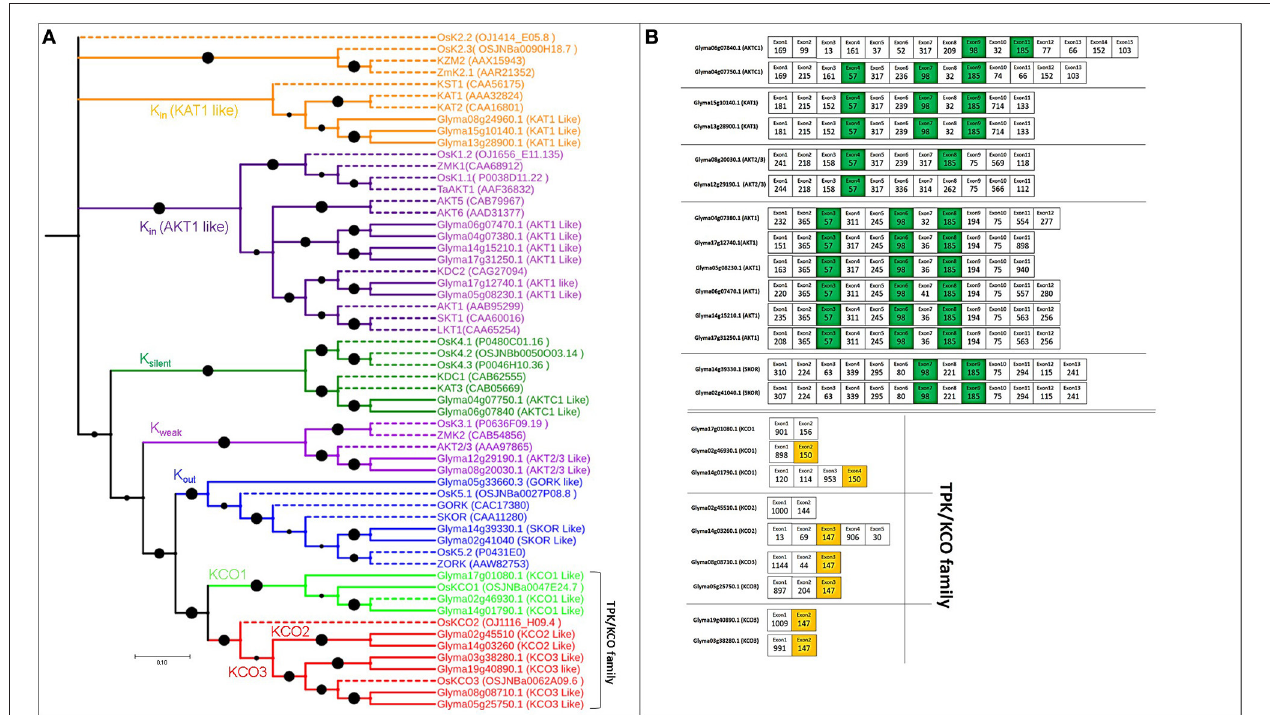
FIGURE 2 | Phylogenetic tree of putative Voltage-gated K + channel and TPK/KCO genes in soybean, with exon structure and splice site analysis. (A) Evolutionary relationships among genes encoding voltage-gated and TPK/KCO channels. Extensive functional analysis identified K in , K out , K weak , and K silent channel subunits in the voltage-gated family that modulates K + uptake. The TPK/KCO family clearly splits into two main groups, shown in bright green and red. Reference genes for constructing the phylogenetic tree are indicated in dotted lines with their NCBI gene names. (B) Exons colored green and orange are conserved in length among all soybean voltage-gated and TPK/KCO channels, respectively.